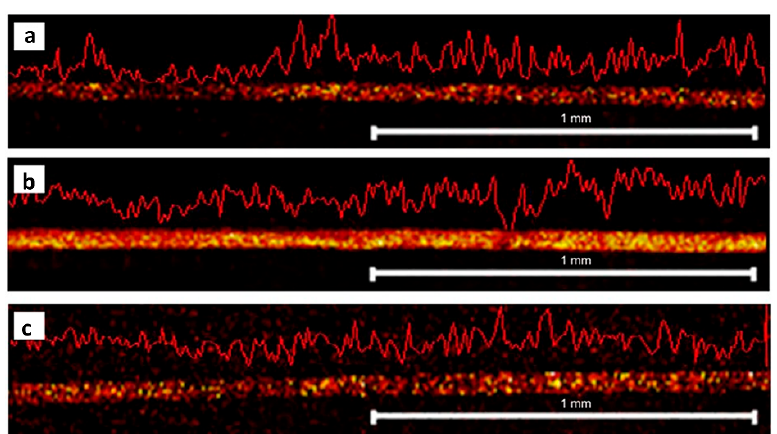
Figure 6. Images show the preparation of longitudinal sections of single hair samples. ( a ) The device with 20–80 µm grooves used for longitudinal sectioning of hair samples; ( b ) Longitudinal hair sections are attached into double-sided copper tape; ( c ) Optical images of the longitudinal sections of single hairs. This device was designed based on references [76,106]. Photos by the authors.